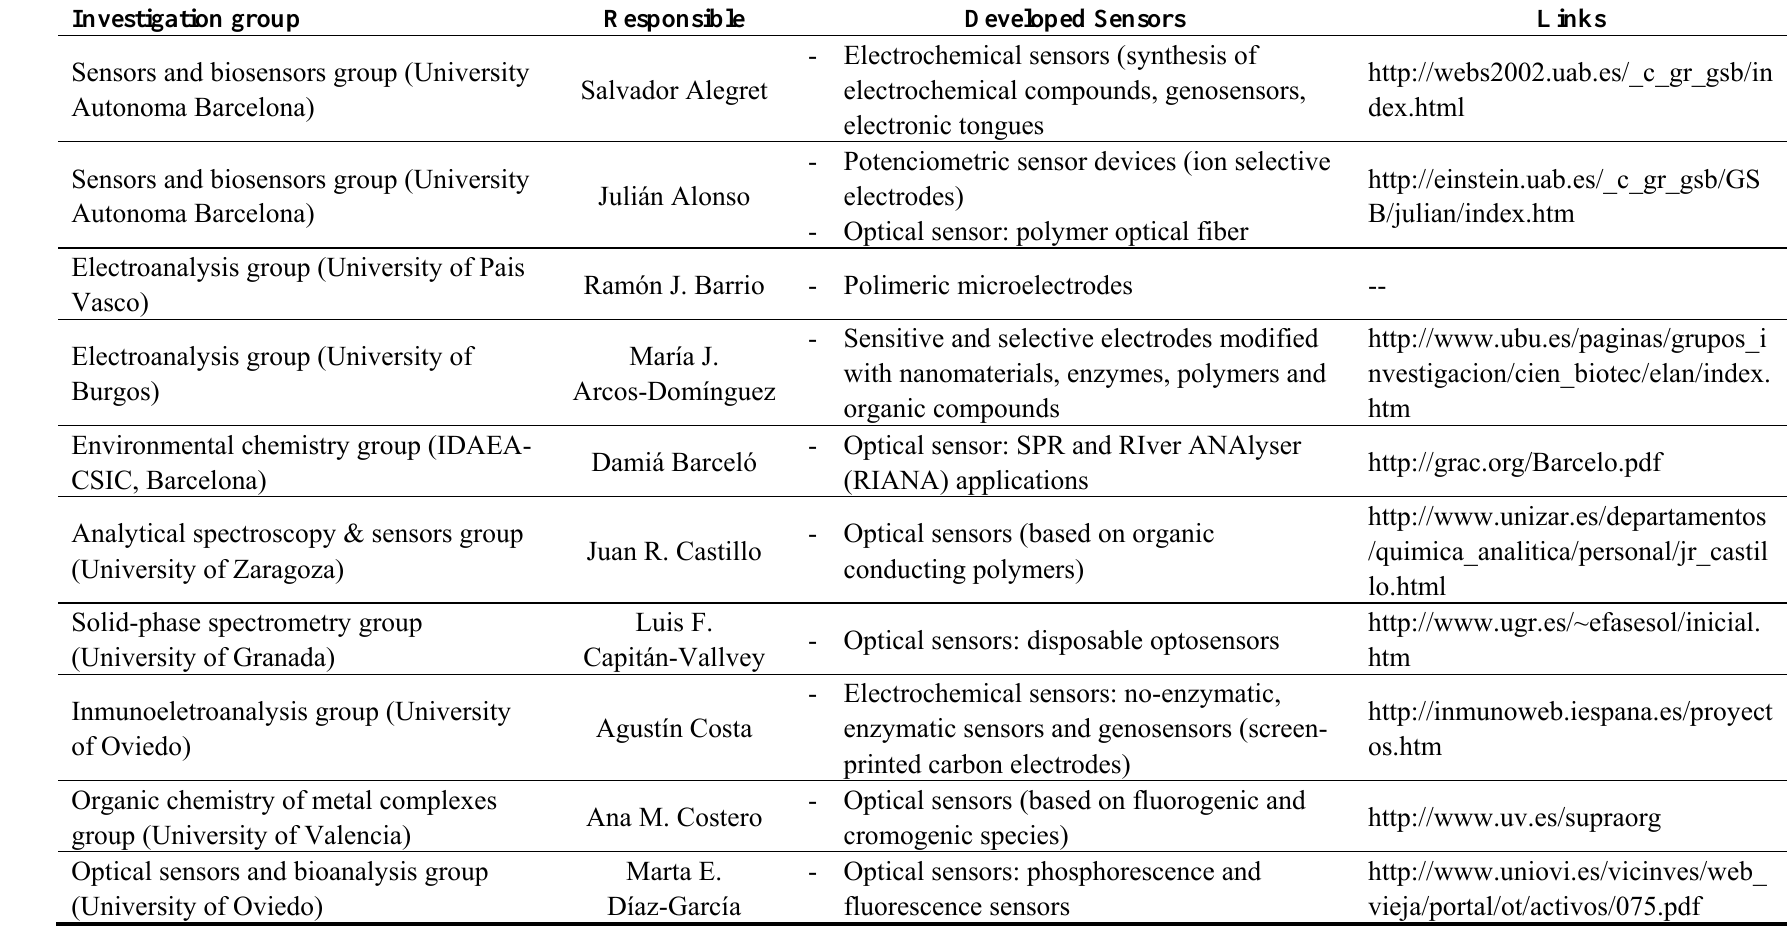
Table 1. Spanish analytical groups and developed